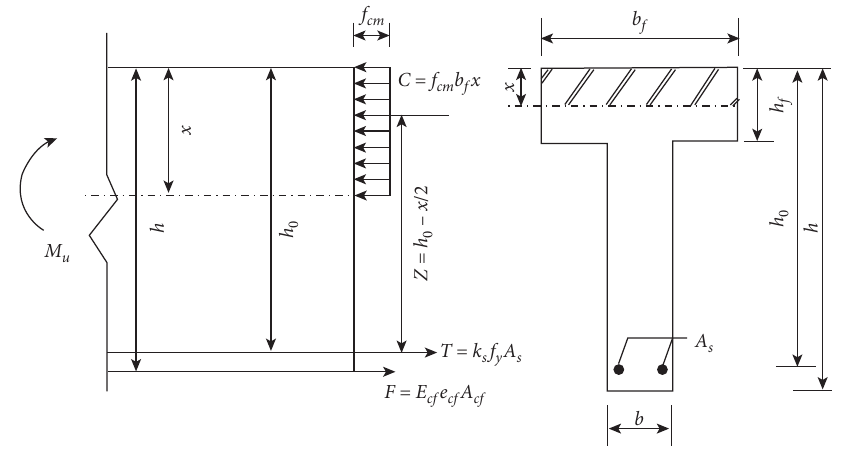
Figure 1: Structure